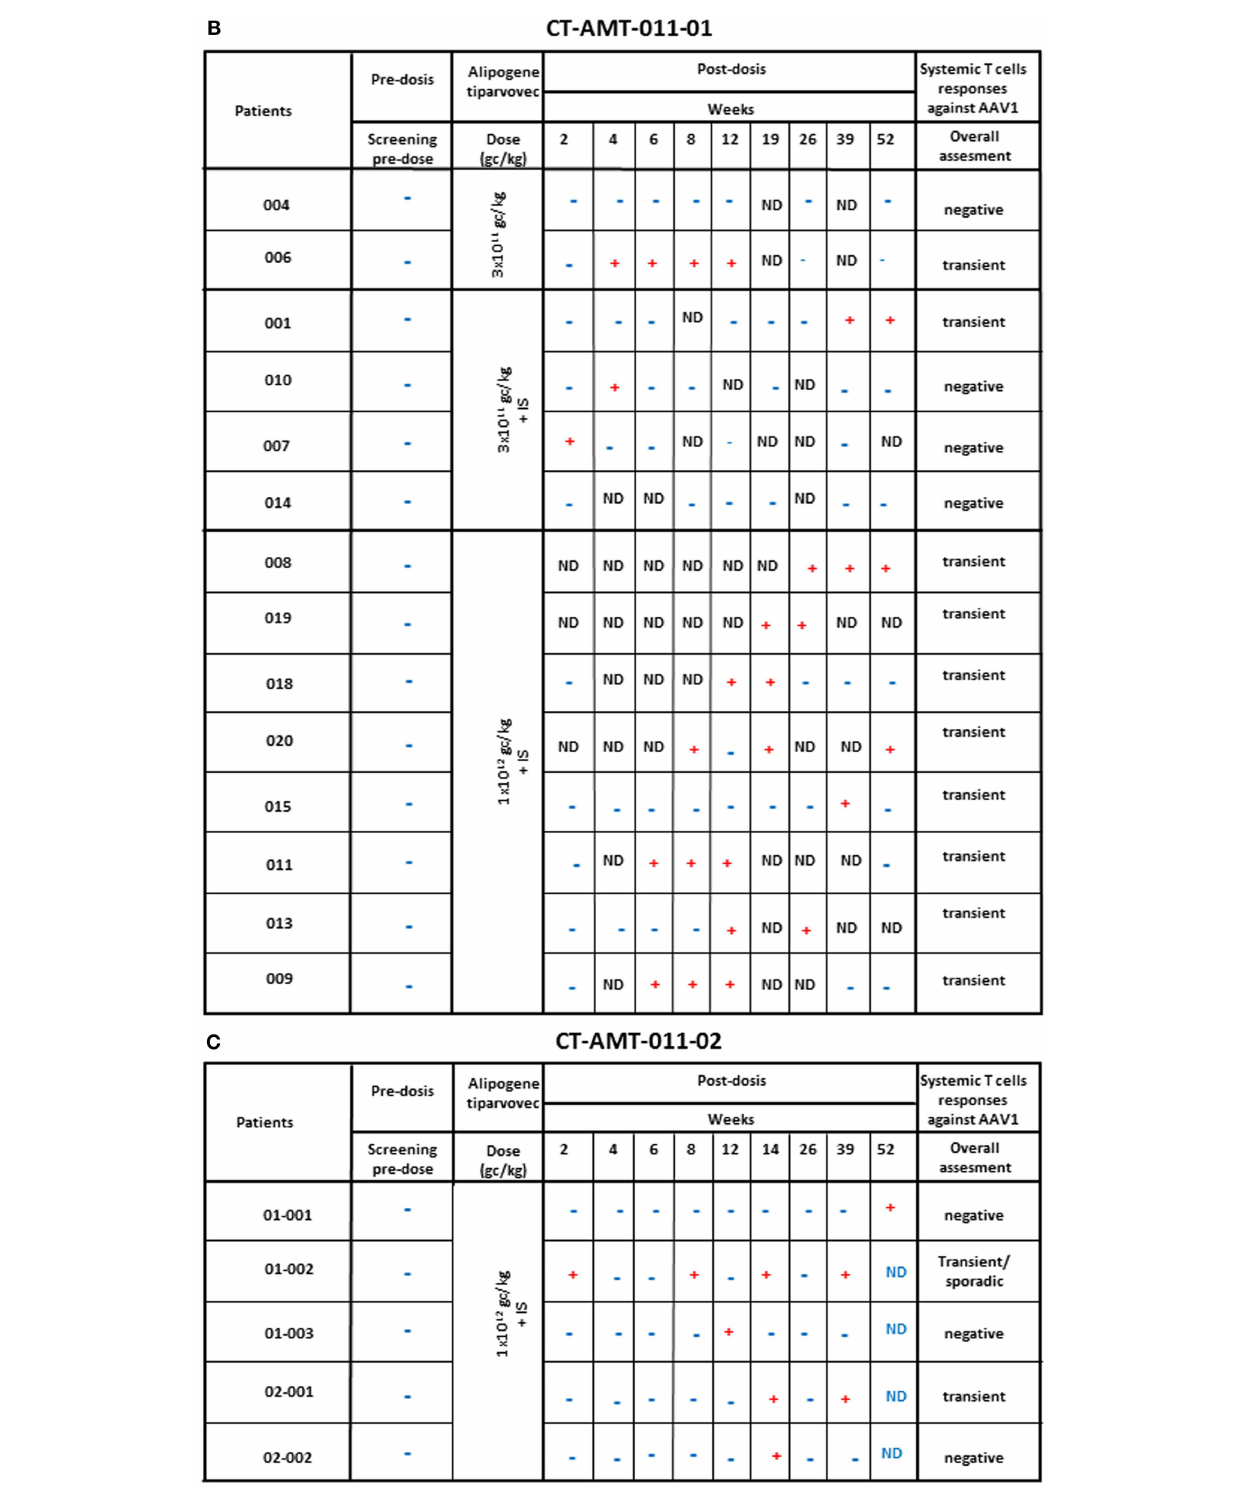
developed aT-cell-mediated immune response to AAV1 capsid proteins when at least two of the eight to nine sampling time points were measured positive ( + ) in the ELISpot assay.When only one sampling time was reported positive ( + ), theT-cell response was considered